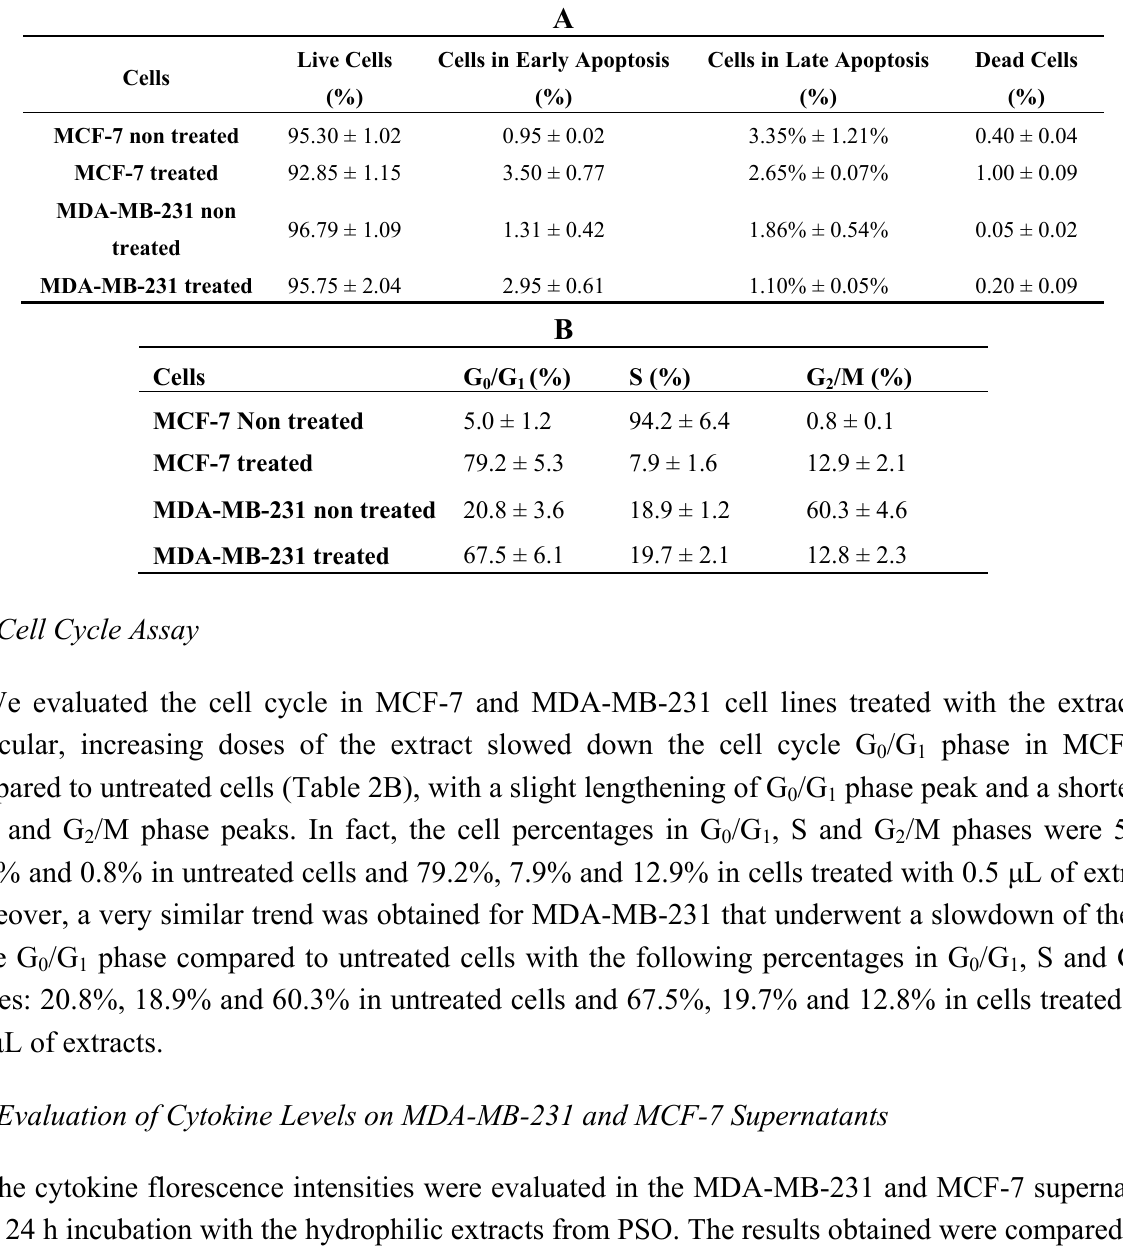
/G , S and G /M phases ( B ) 0 1 2